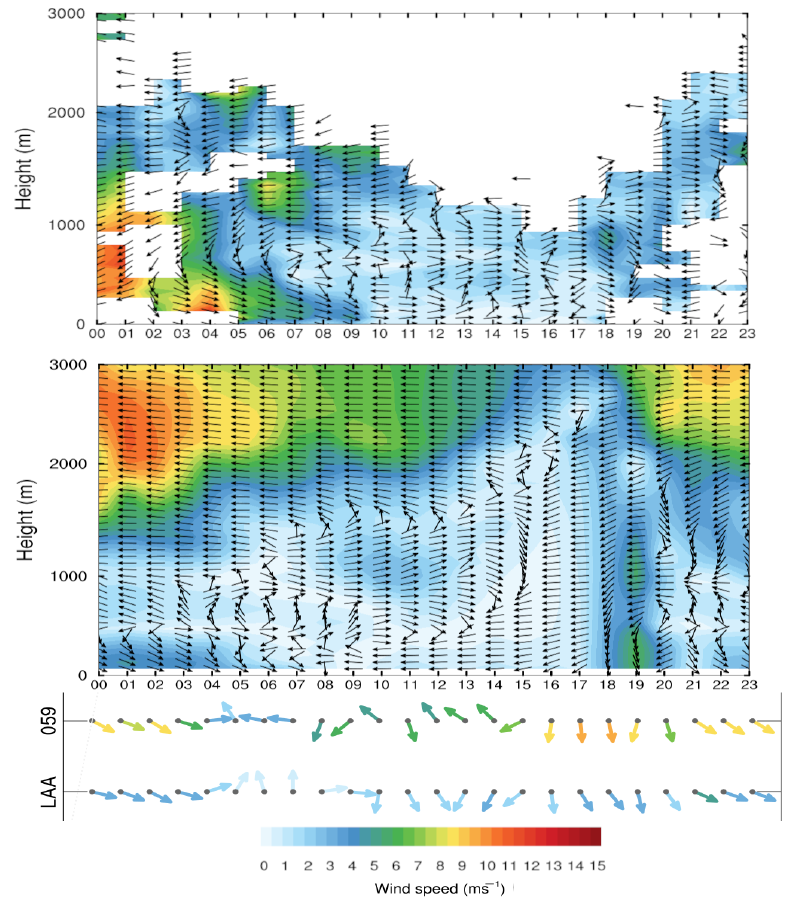
Figure 6. Height versus time horizontal of observed and modeled horizontal Wind profiles for 10 February 2017 at the location of the Radar Wind Profiler ( upper panel ), the corresponding nearest grid point from the CTRL simulation ( middle panel ), and the two nearest weather stations to the Radar Wind Profiler site, LAA and 059 ( lower panel ). The magnitude of the wind in the CTRL, the RAWP and the wind field from the two stations is represented by the color bar in the lower